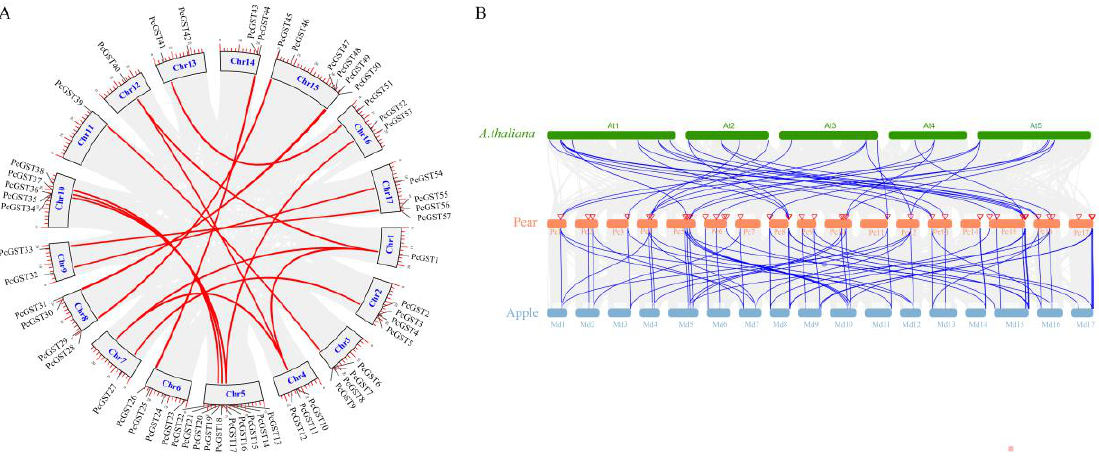
Figure 3. Collinearity analysis of the pear PcGST gene family. ( A ) Collinearity relationships of PcGST genes in pear genome. The panel exhibited 17 pear chromosomes in a circle with red lines connecting PcGST genes with WGD/segmental duplication events. Chromosome numbers were indicated on the circle with blue color. The PcGST genes were mapped to the chromosomes outside the circle. ( B ) Collinearity relationships of PcGST genes in pear, Arabidopsis , and apple. The blue lines indicated the PcGST genes with homologous relationship with Arabidopsis or apple.